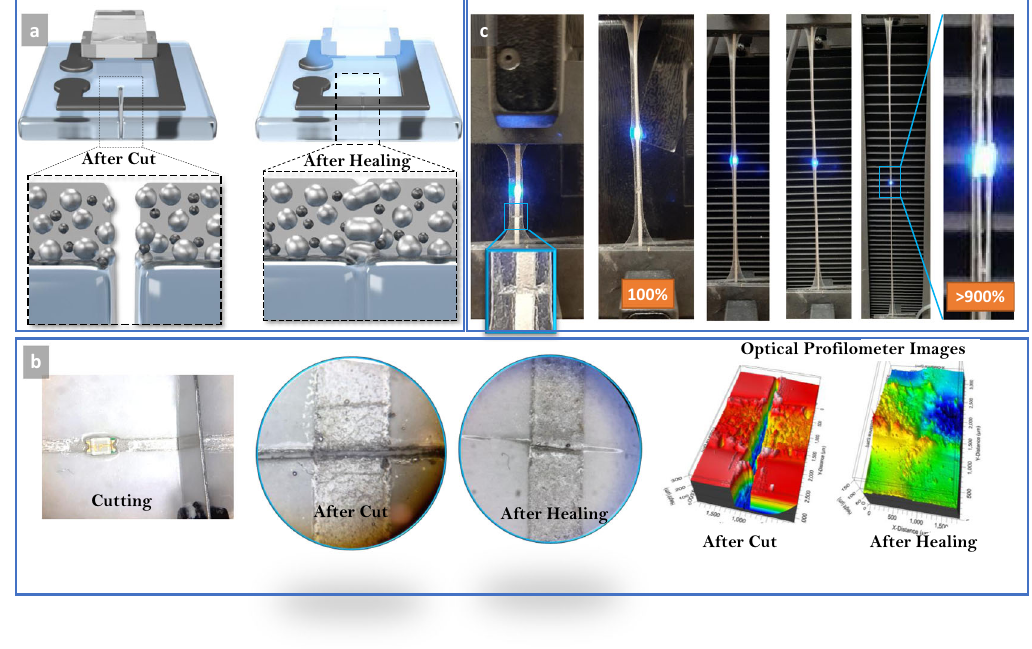
Fig. 5 The self-healing process. a Schematics of the healing process. b Image from the sample undercut, after a deep cut of the ink and the substrate, and after healing through vapor exposure. Optical pro fi lometer images of the cut before and after healing. c A dully cut and healed sample under tensile strain test of 900%, and the magni fi ed image of the sample prior to breaking.